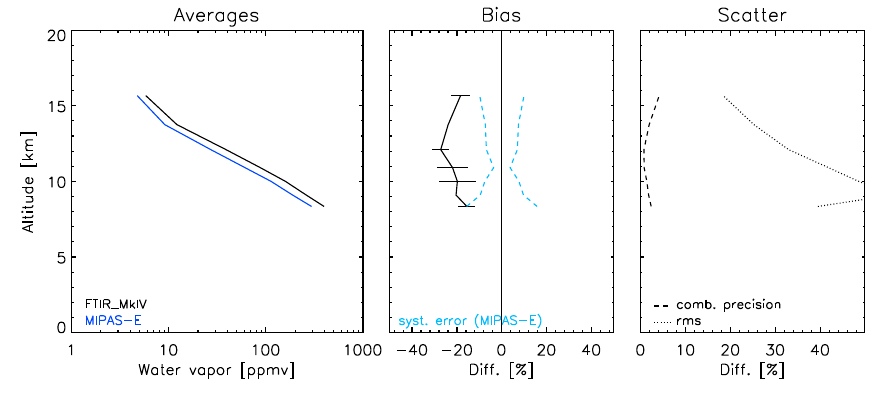
Fig. 13. Same as Fig. 9 but for MkIV FTIR spectrometer water vapor profiles. For a more detailed description see Fig. 9.